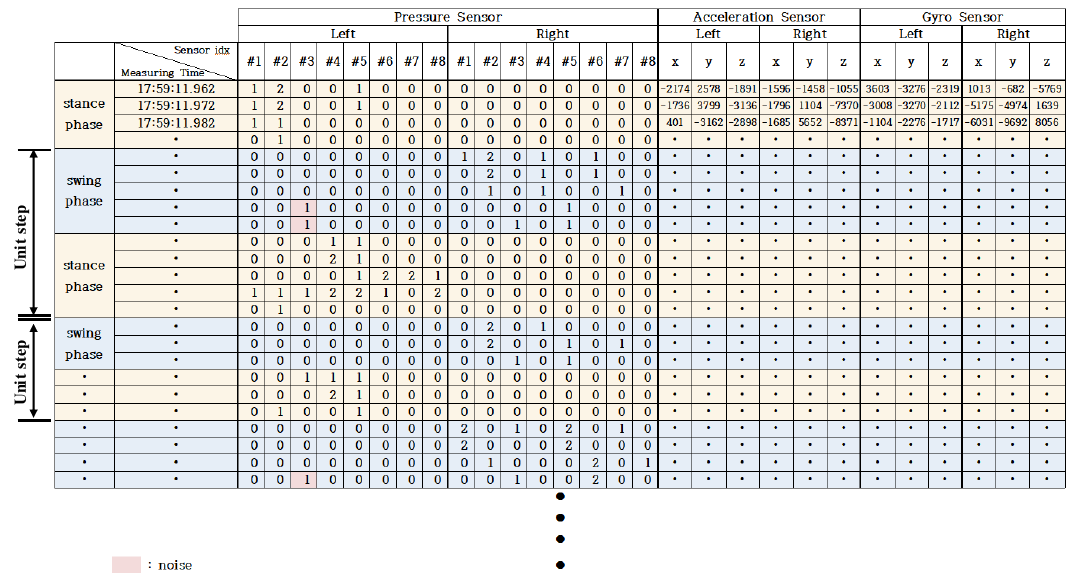
Figure 3. Example of gait data measured using ‘FootLogger’.